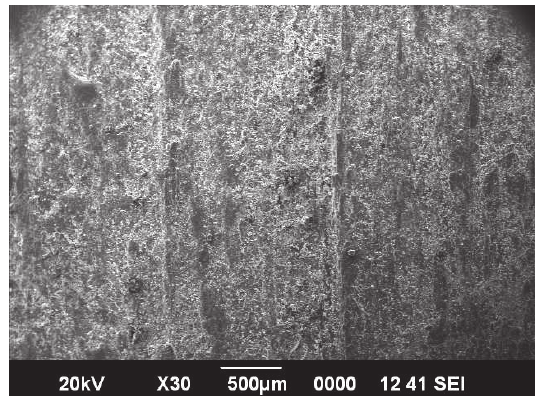
Fig. 9. SEM image of Al-Si alloy after machining